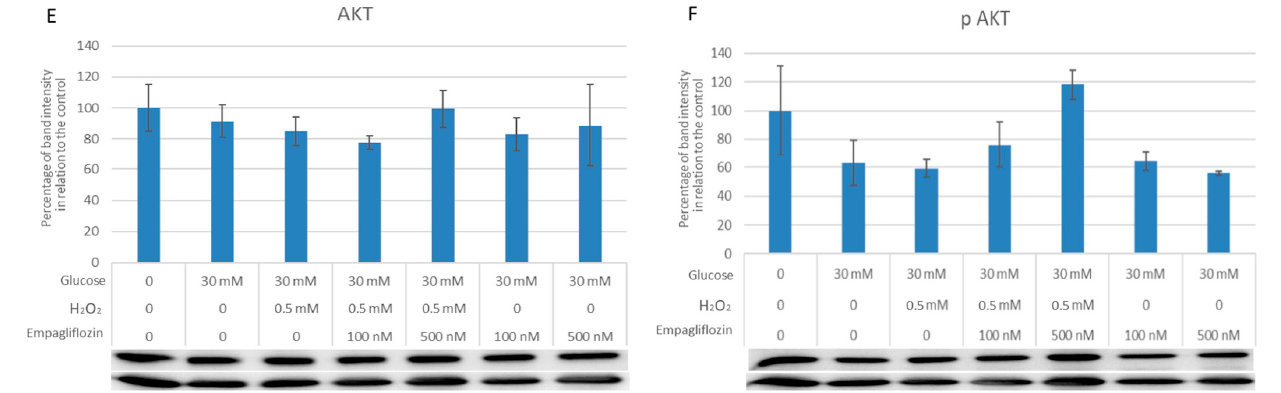
Figure 3. Effects of empagliflozin on protein expression Akt, pAkt, GSK3, pGSK3, pSTAT3, and SMAD7. ( A – F ) in LLC-PK1 cell line. The data are shown as the means ± SD (standard deviation) from three biological replicants. Values below the x -axis indicate the quantity of compounds. One- way ANOVA F(6,19) = 3.349, p = 3.21 × 10 − 2 with Tukey HSD post hoc test; * p < 0.05, ** p < 0.01; *** p < 0.001. pSTAT3 signal transducer and activator of transcription 3, GSK3 β glycogen synthase kinase 3 β , pGSK3 β phosphorylated GSK3 β , SMAD, AKT actin, pAKT actin.